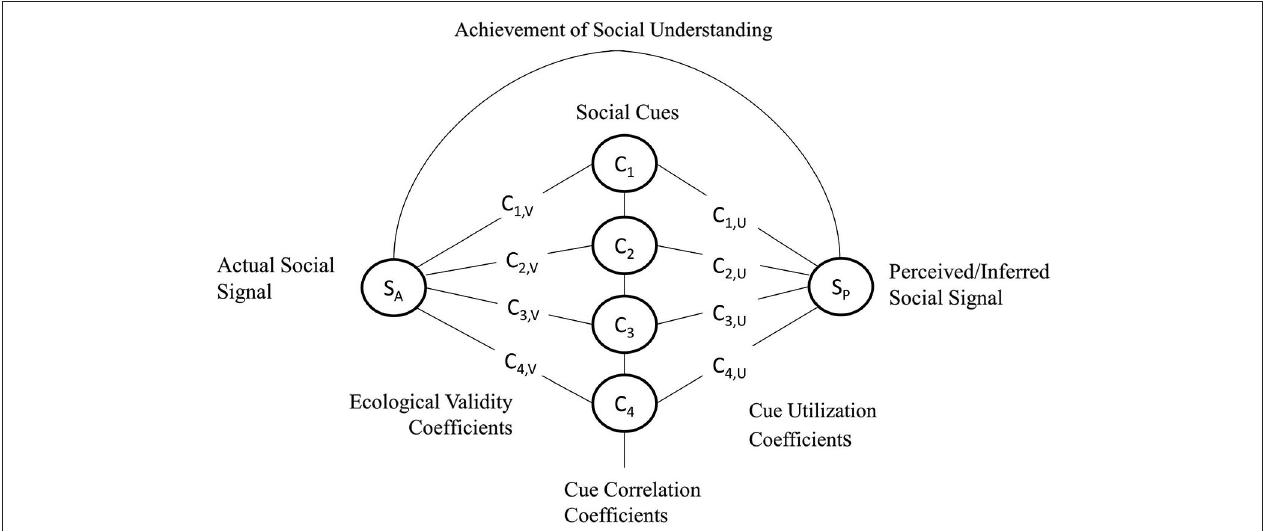
FIGURE 2 | A social cues and signals depiction of the Lens Model (Adapted from the works of Hammond, 1993; Cooksey, 1996; Doherty and Kurz, 1996; Vicente, 2003)